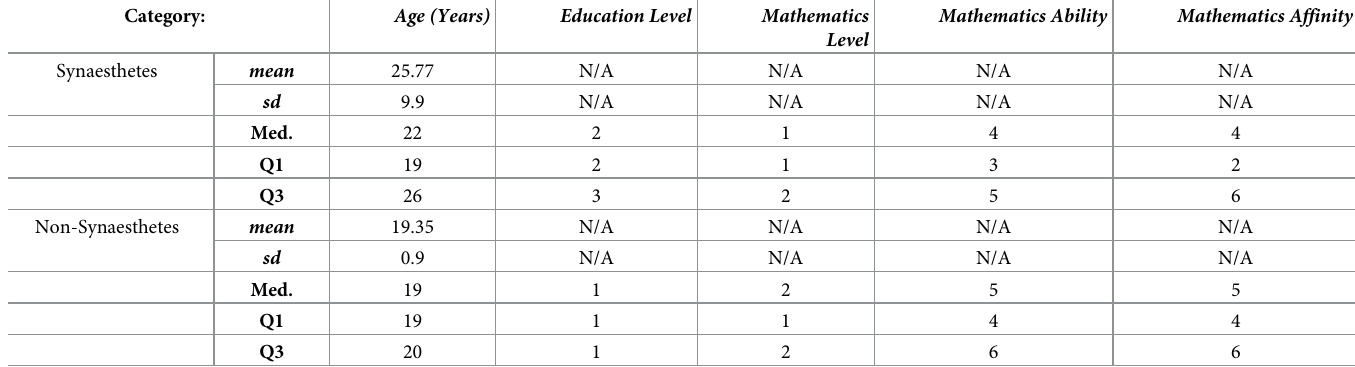
Quantitative results. The Synaesthetes and Non-Synaesthetes ~ x were 10.9 s and 9.9 s, RTs respectively; between conditions the ~ x were 10.6 s (Congruent), 11.1 s (Incongruent), and RTs 10.8 s (Control) for the Synaesthetes and 10.1 s (Congruent), 9.9 s (Incongruent), and 9.7 s (Control) for the Non-Synaesthetes. We computed two models to estimate each population’s (i.e. ^ m ) by condition. For each, we modelled response times from the shifted log- mean ~ x RT RT normal family function using the participants’ results and the formula Response Time ~ Con- dition + Condition + (1|ID). We used the estimates from the posterior distribution of the first model as priors when modelling for the Synaesthetes and did not specify informative priors for the Non-Synaesthetes. We then plotted the models’ estimates for the ^ m s , within their 95% RT CI for the Non-synaesthetes [Congruent ^ m = 10.1 s, 95% CI (9.5 s, 10.8 s); Incongruent ^ m = IT IT dition (see Fig 4 A ).